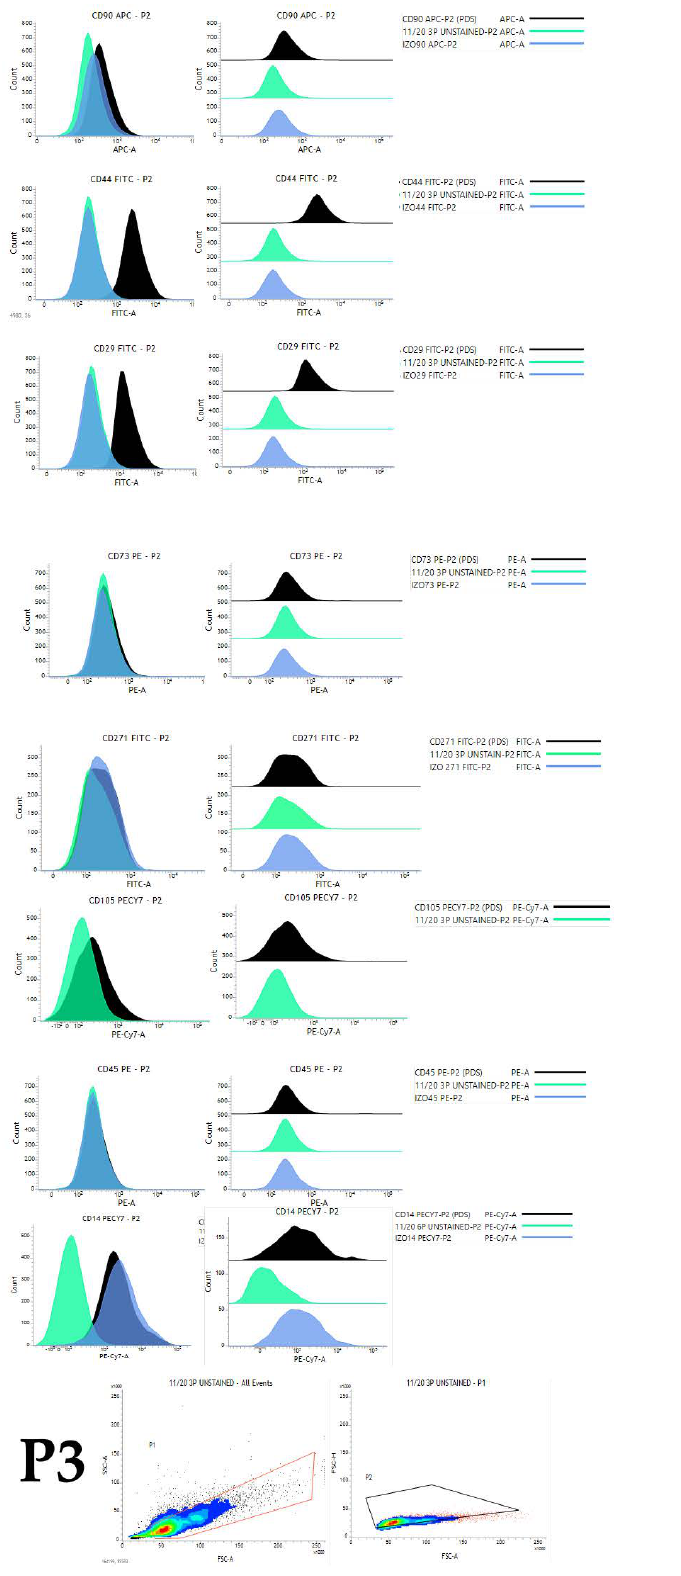
Figure 6. Histogram representation of immunophenotyping results obtained by flow cytometry analysis of cells in passage 3 originating from representative young female canine donor. Histogram presents overlayed unstained population (green), appropriate isotype control (blue) and fully stained population of cells